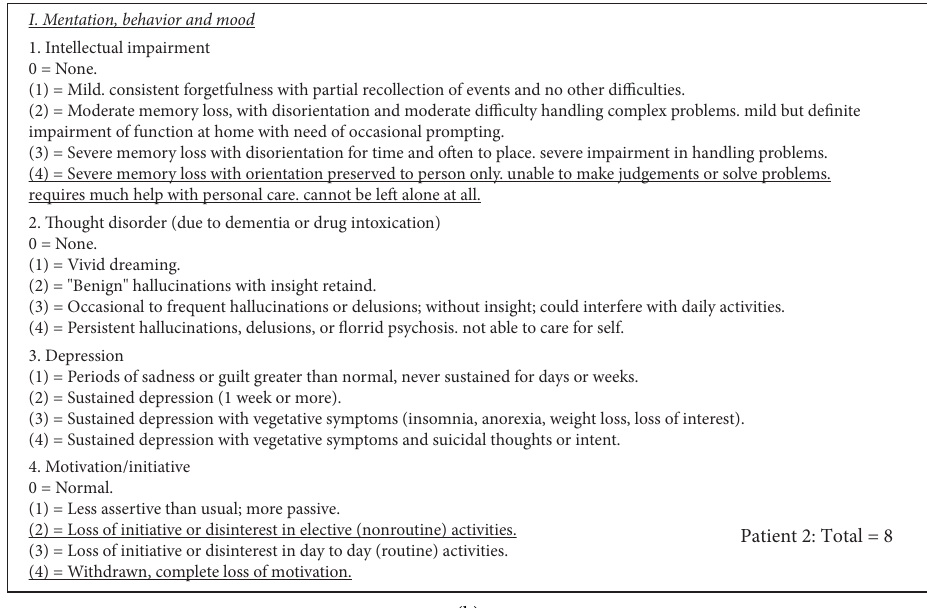
Figure 3: Illustration of same totals with choice combinations in the UPDRS part I (scale from [10]). (a) Patient 1: total � 8. (b) Patient 2: total � 8.